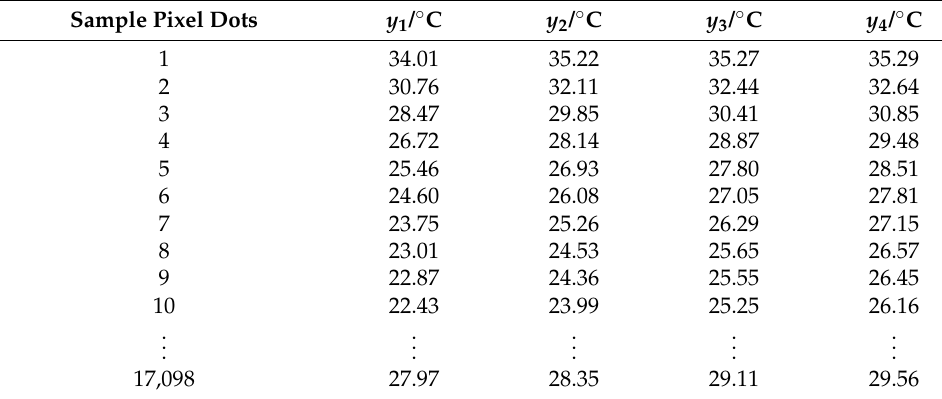
Figure 8. Pseudo-color labeled image. Figure 8. Pseudo ‐ color labeled image. Table 2. Temperature statistics of each pixel point at different